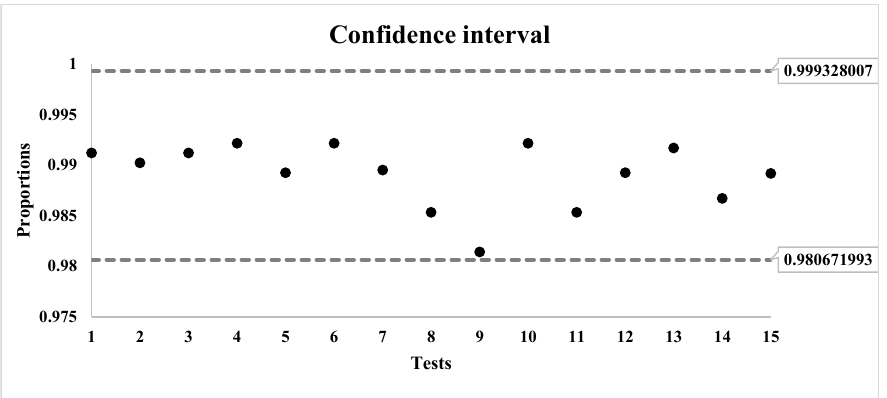
Figure 1. Confidence interval of the STS statistical tests.